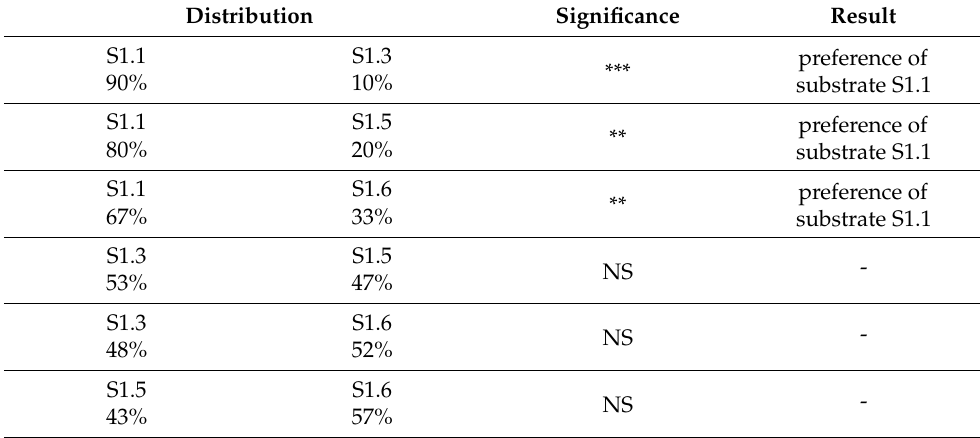
Table 5. Results of the avoidance test with the earthworms Eisenia andrei exposed to a first set of tested substrates for 48 h.